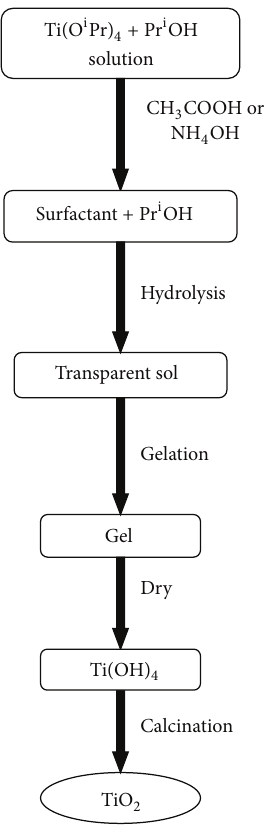
Scheme 1: Preparation of TiO 2